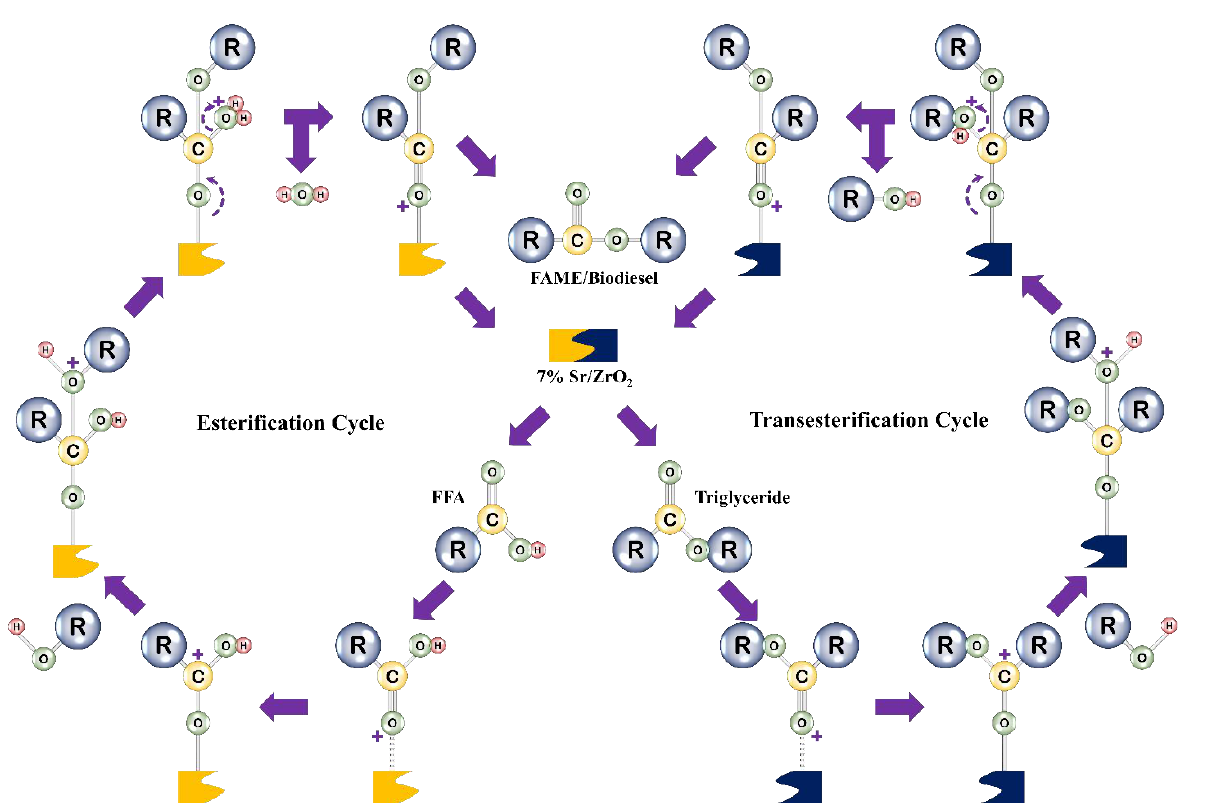
Figure 7. Proposed reaction of 7% Sr/ZrO 2 for converting WCO into biodiesel.